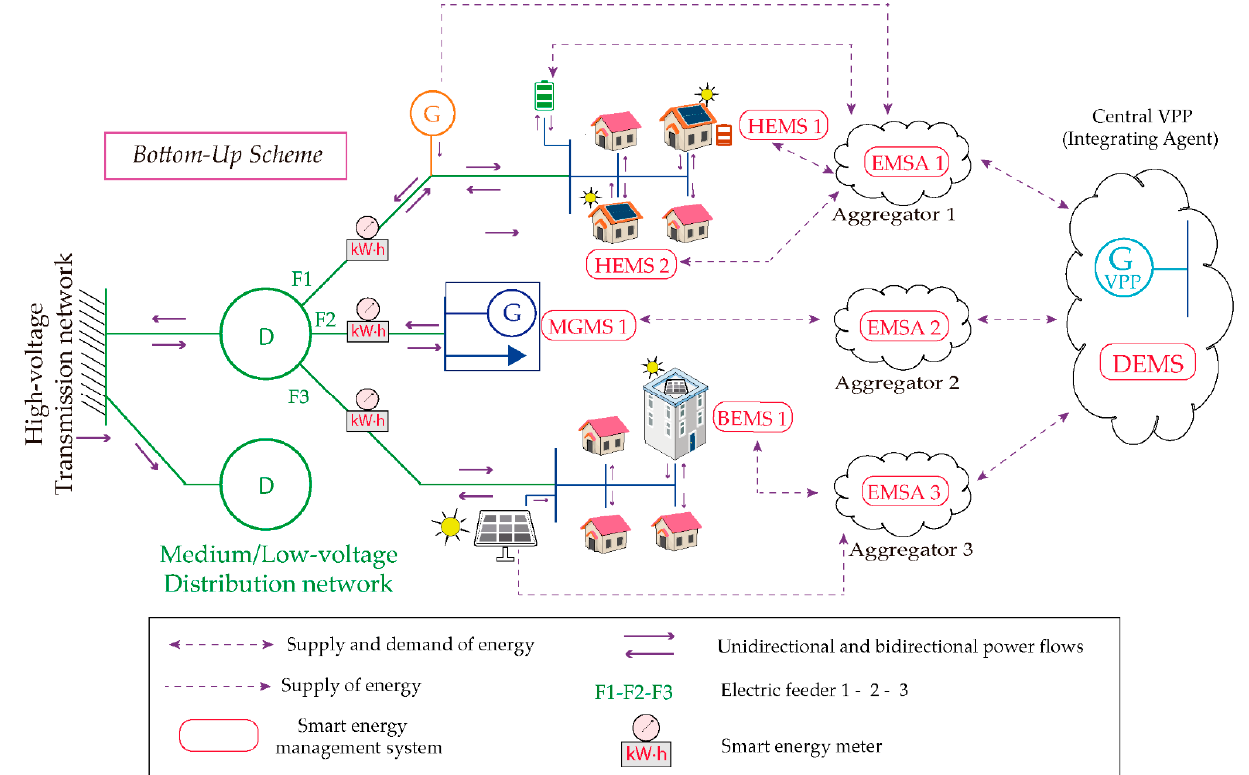
Figure 6. Operational architecture of a smart grid with NZEG objectives .